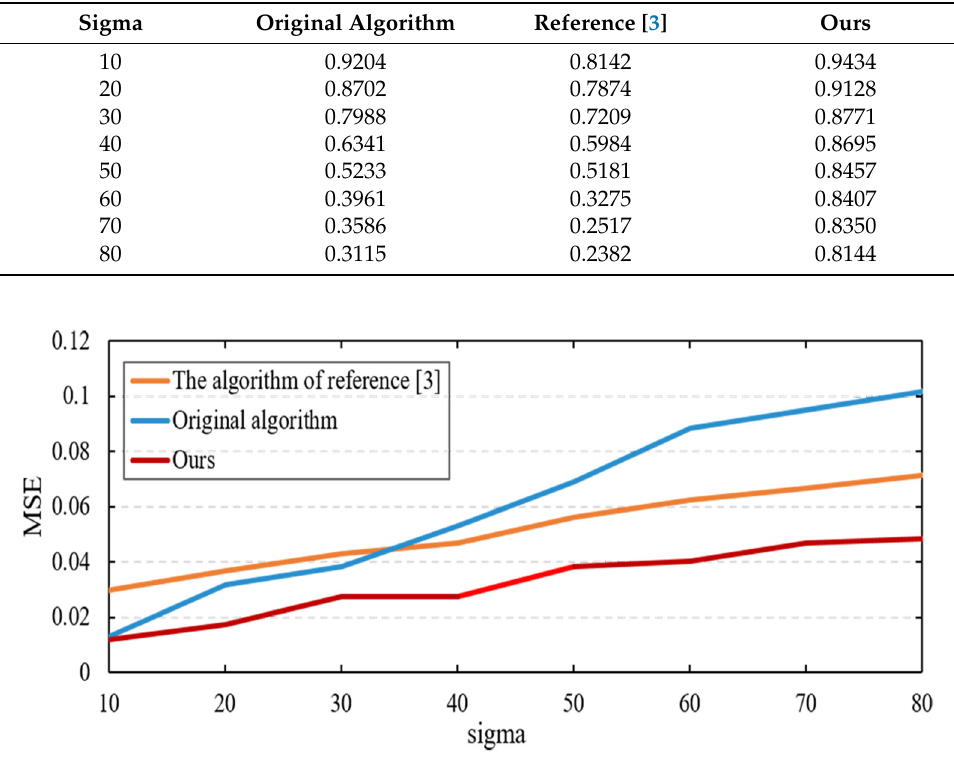
Figure 3. PSNR line chart of the three algorithms for the Cameraman image. Figure 4. SSIM line chart of the three algorithms for the Cameraman image. Figure 4. SSIM line chart of the three algorithms for the Cameraman image.